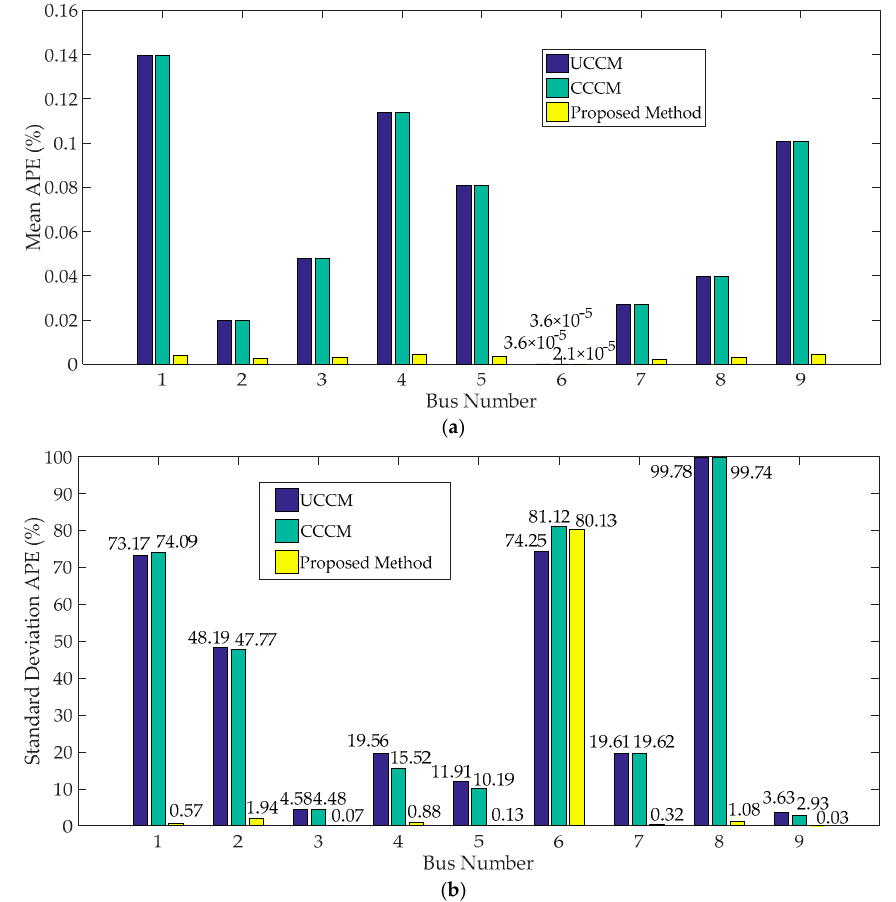
Figure 4. Comparison of APE values of voltage magnitude at each bus (modified IEEE 9-bus test system). ( a ) Mean APE values; ( b ) Standard deviation APE values.